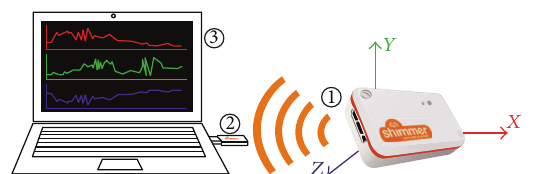
Figure 2: System 1—fall detector. (1) Shimmer 2R with accelerome- ter. (2) 802.15.4 receiver. (3) Base station.